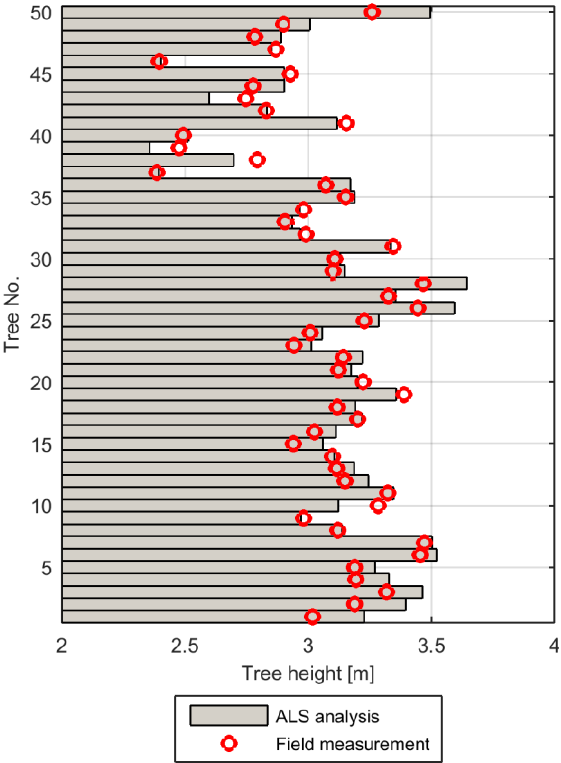
Figure 5. Comparison of tree heights obtained from LiDAR data Figure 4. Result of tree crown delineation for a part of study analysis and field measurements for 50 reference area